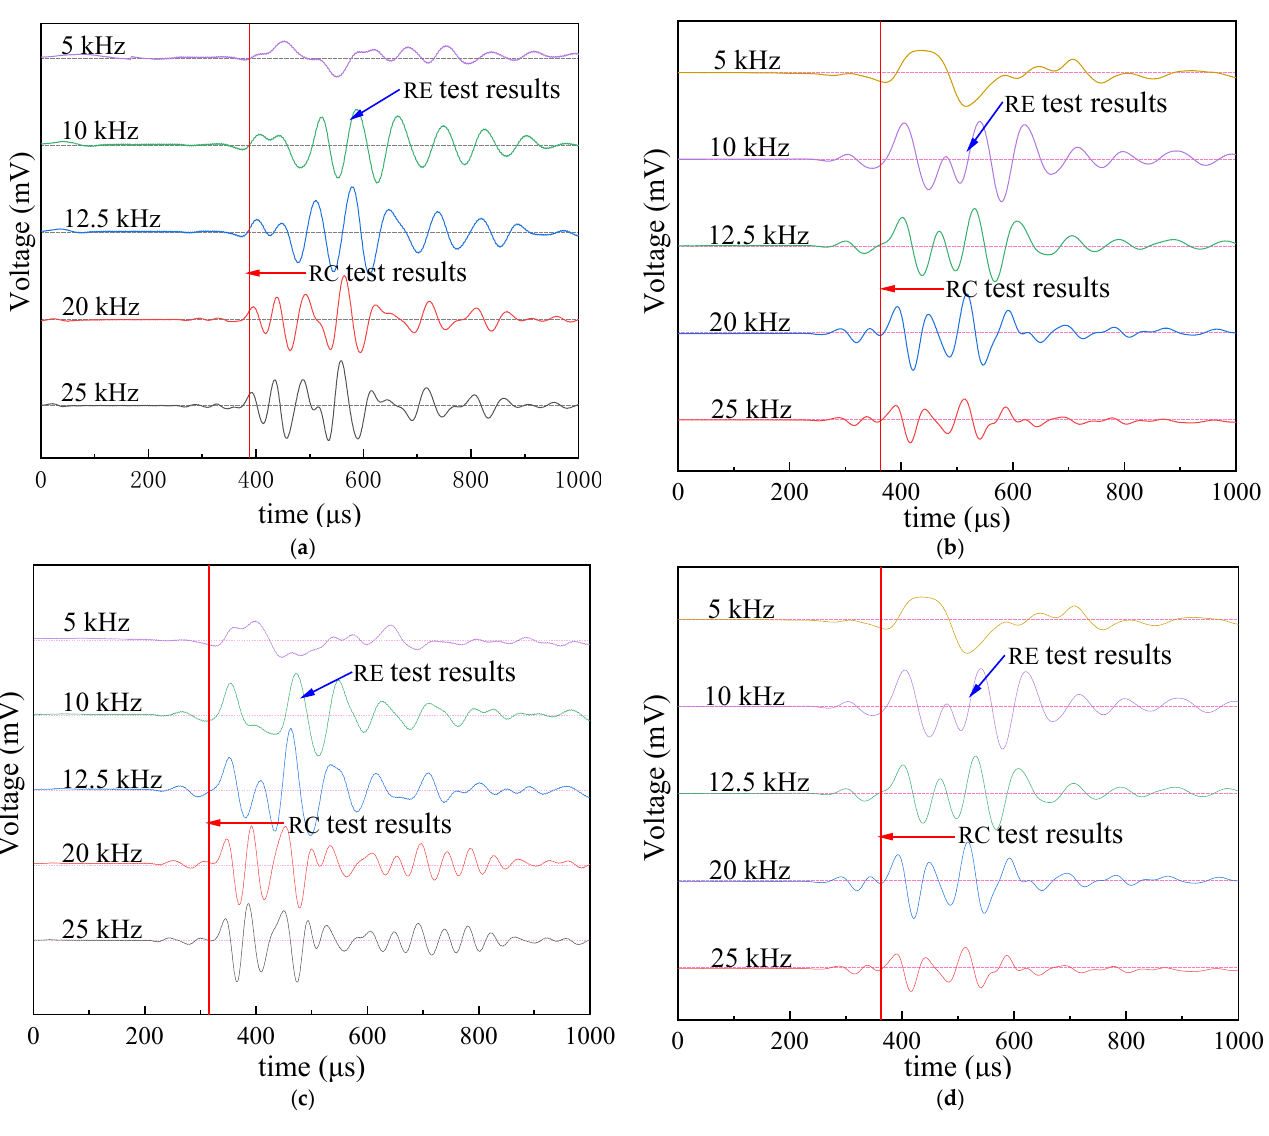
Figure 3. The results of the BE-RC test of silty fine sand under different net stresses. ( a ): Sr = 0, net stress = 200 kPa; ( b ): Sr = 1, net stress = 200 kPa; ( c ): Sr = 0, net stress = 400 kPa; ( d ): Sr = 1, net stress = 400 kPa.